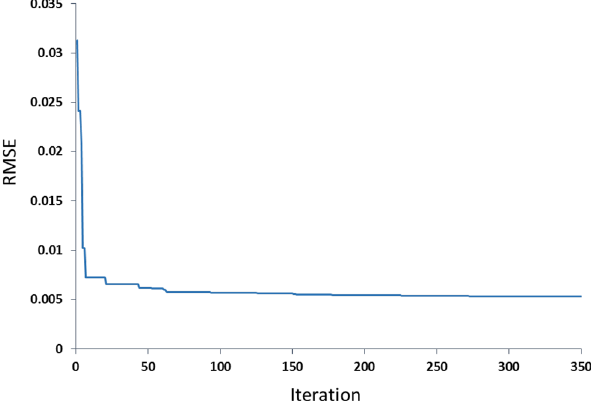
Fig. 7 Acquired RMSE by each iteration epoch of TLBOFIS (clustering radius = 0.6) in training